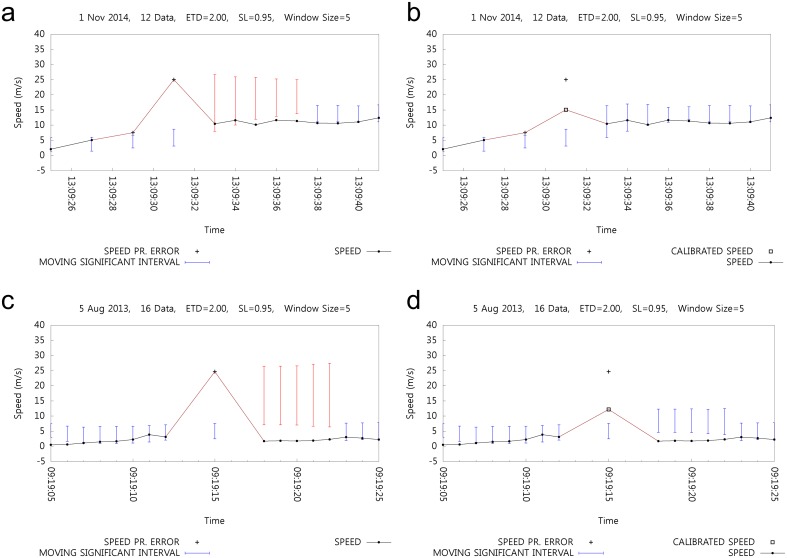
Calibration of Erroneous Speeds.